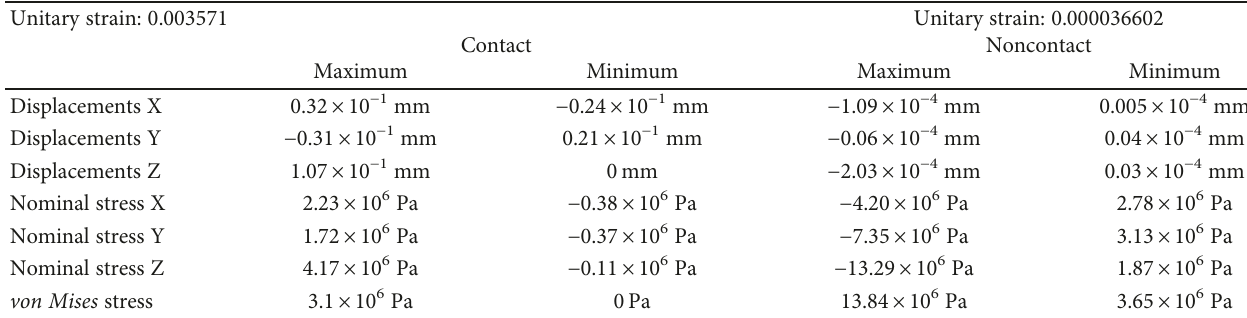
Table 5: Simulation results for a load of 50 N/mm 2